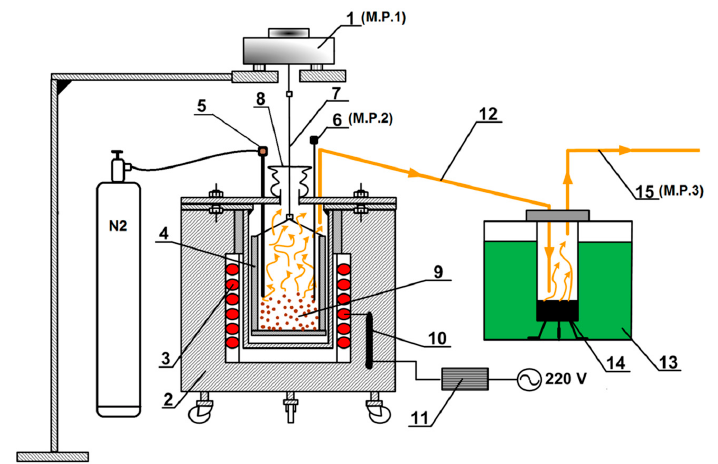
Figure 1. Scheme of a laboratory plant for pyrolysis [23]. 1—digital scale (M.P.1), 2-pyrolysis reactor, 3-electric heaters, 4—reactor vessel, 5—N 2 cylinder with flowmeter, 6—thermocouple (M.P.2), 7—connection between scale and reactor vessel, 8—flexible teflon sheath, 9—tested sample of waste tires, 10—temperature regulator sensor, 11—temperature regulator, 12—volatiles outlet,